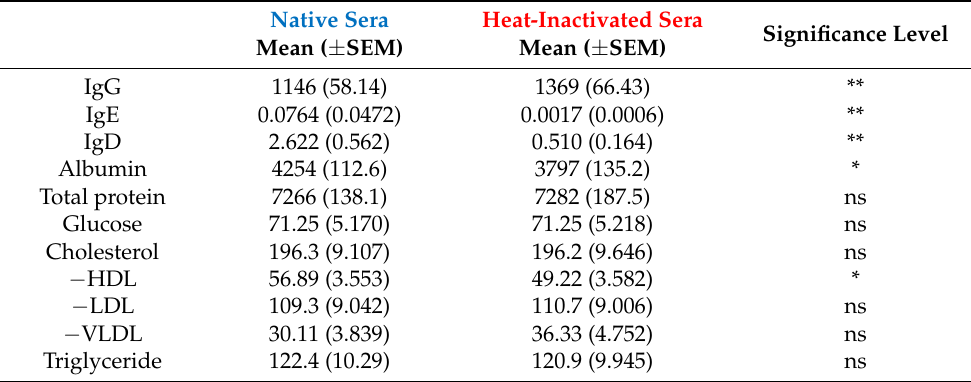
Table 1. Effects of serum heat-inactivation on immunoglobulins, proteins, glucose, and lipids. (mean ± SEM of n = 9, except for IgE, where native n = 9, HI n = 8, and glucose n = 4; Wilcoxon test; * p < 0.05, ** p < 0.01, ns not